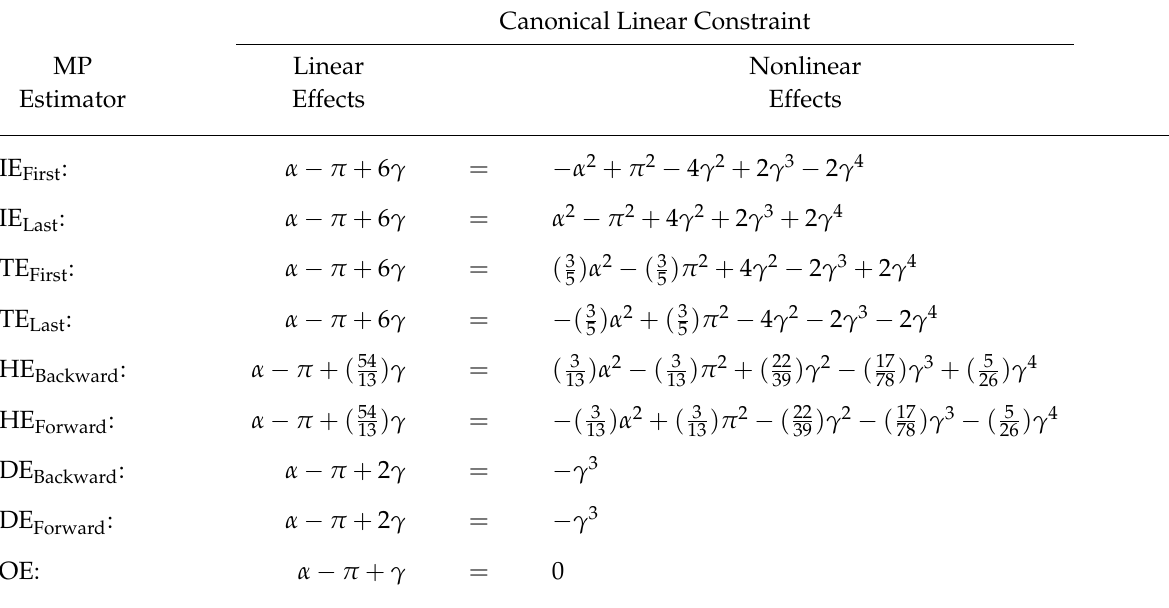
Table 3: Canonical form of linear constraints with I = 3 and J = 3